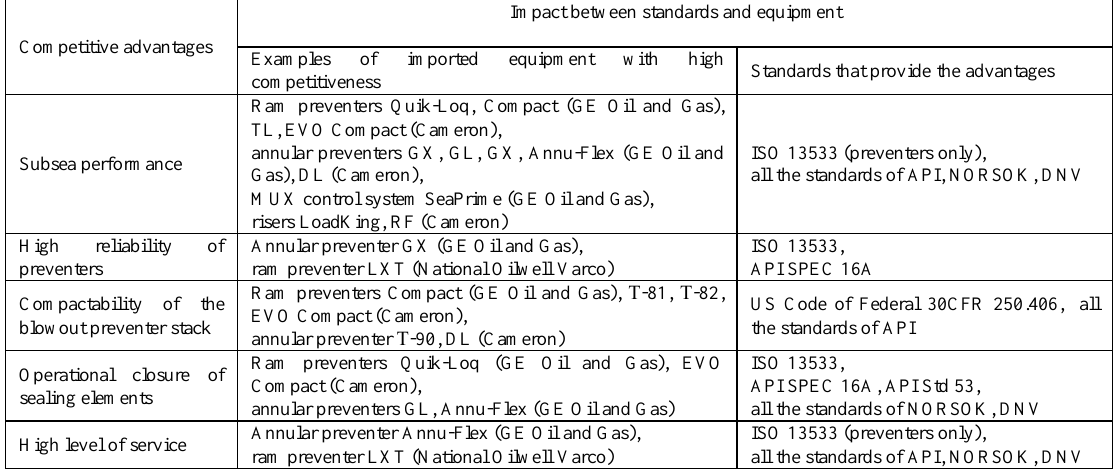
Table 1. Impact of the foreign standards requirements on competitiveness of imported